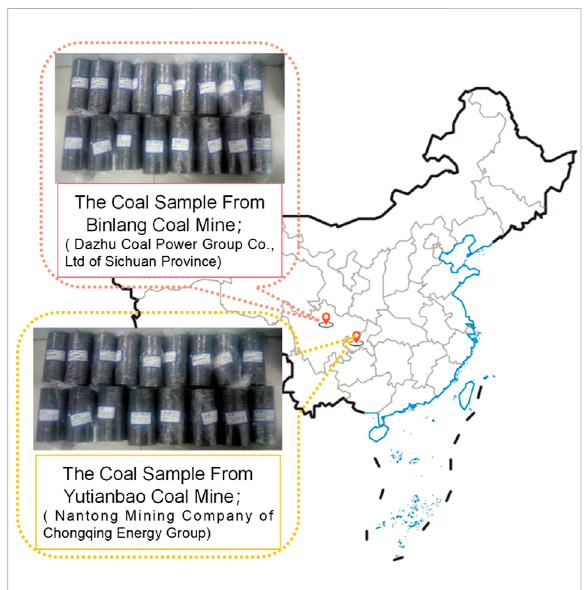
FIGURE 1 Experimentalcoalsamplesarecollectedandstoredinthe fi